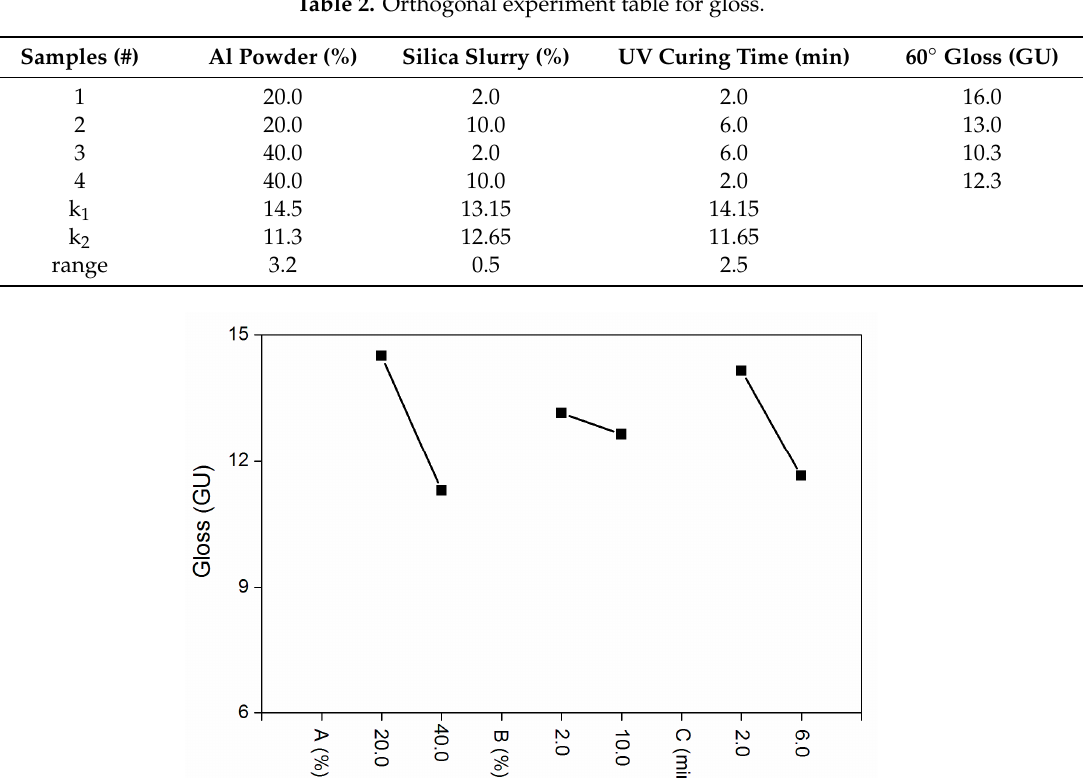
Table 2. Orthogonal experiment table for gloss.